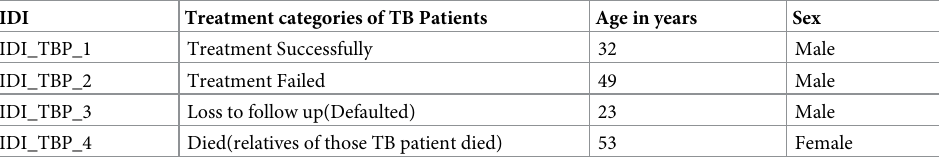
Table 5. In-depth interview for different treatment categories of TB Patients.